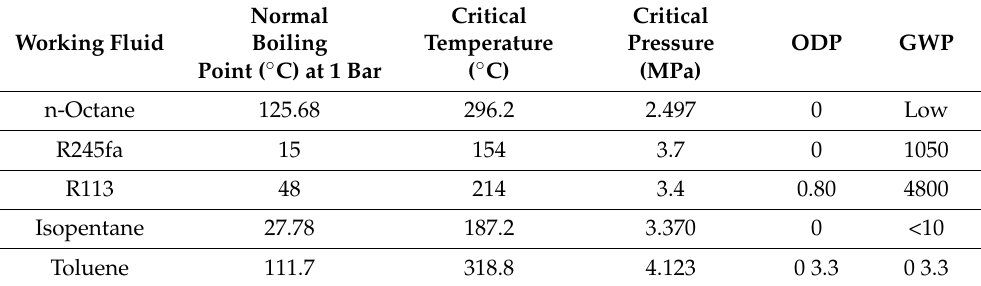
Table 4. Properties of the selected working fluids.